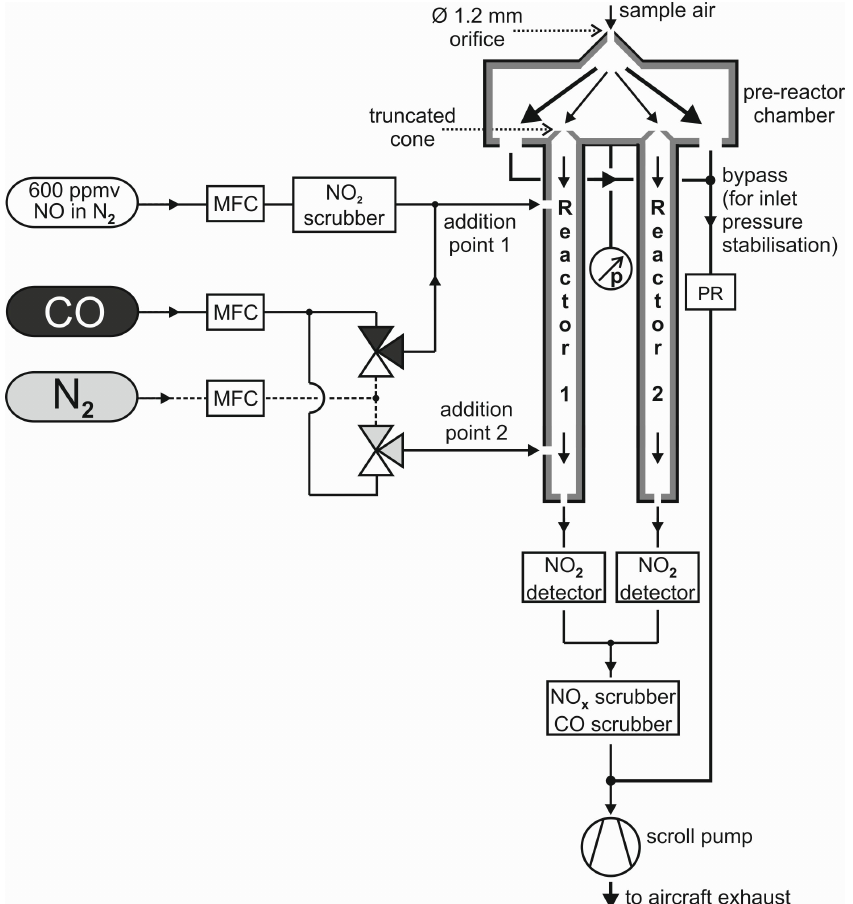
Fig. 1. Pressure and gas flow of the PeRCEAS instrument. Reactor 1 is shown in amplification mode. MFC – mass flow controller, PR – pressure regulator. The sensor between both reactors measures the inlet pressure. The ovals on the left side represent gas cylinders.